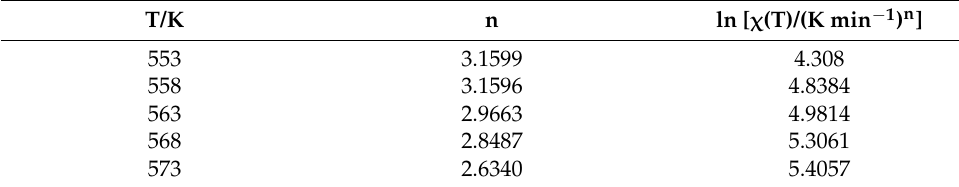
Figure 9. Arrhenius plots of the heating function. Squares and diamonds represent, respectively, ln χ ( T ) and ln χ ( T )/ n values. Dash lines are least square fits to the respective points.